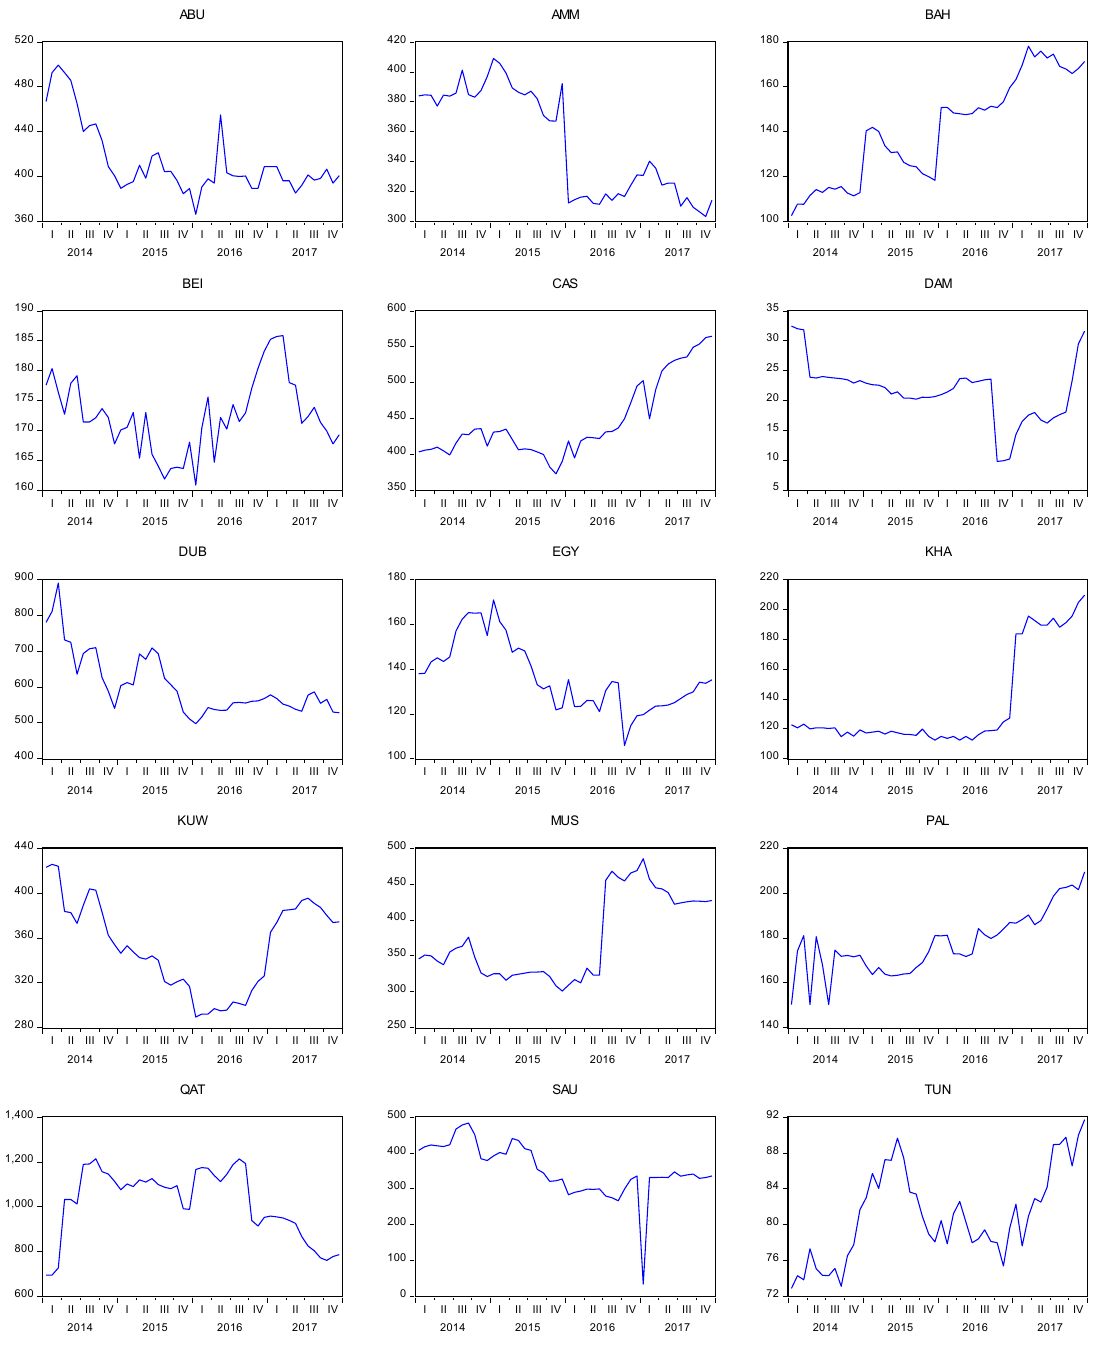
Figure 1. Changes in monthly indices of Arab stock markets,